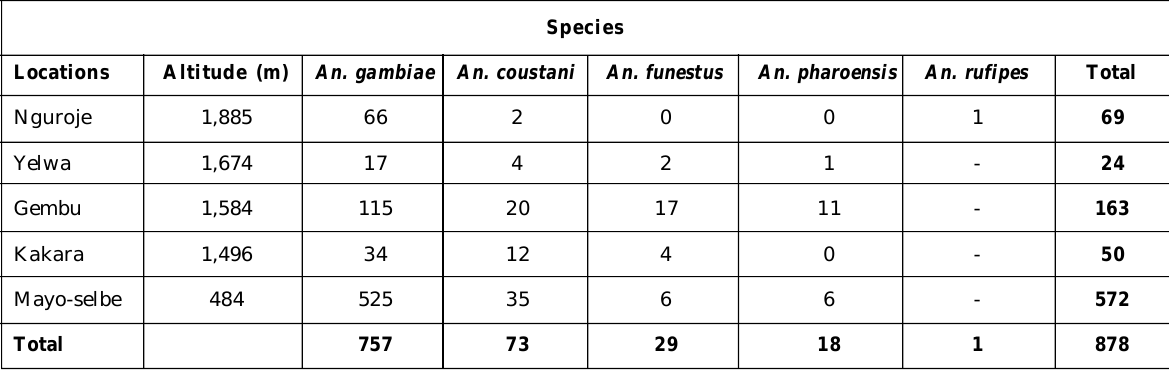
Table 1: Number and species composition of Anopheles mosquitoes along altitudinal locations